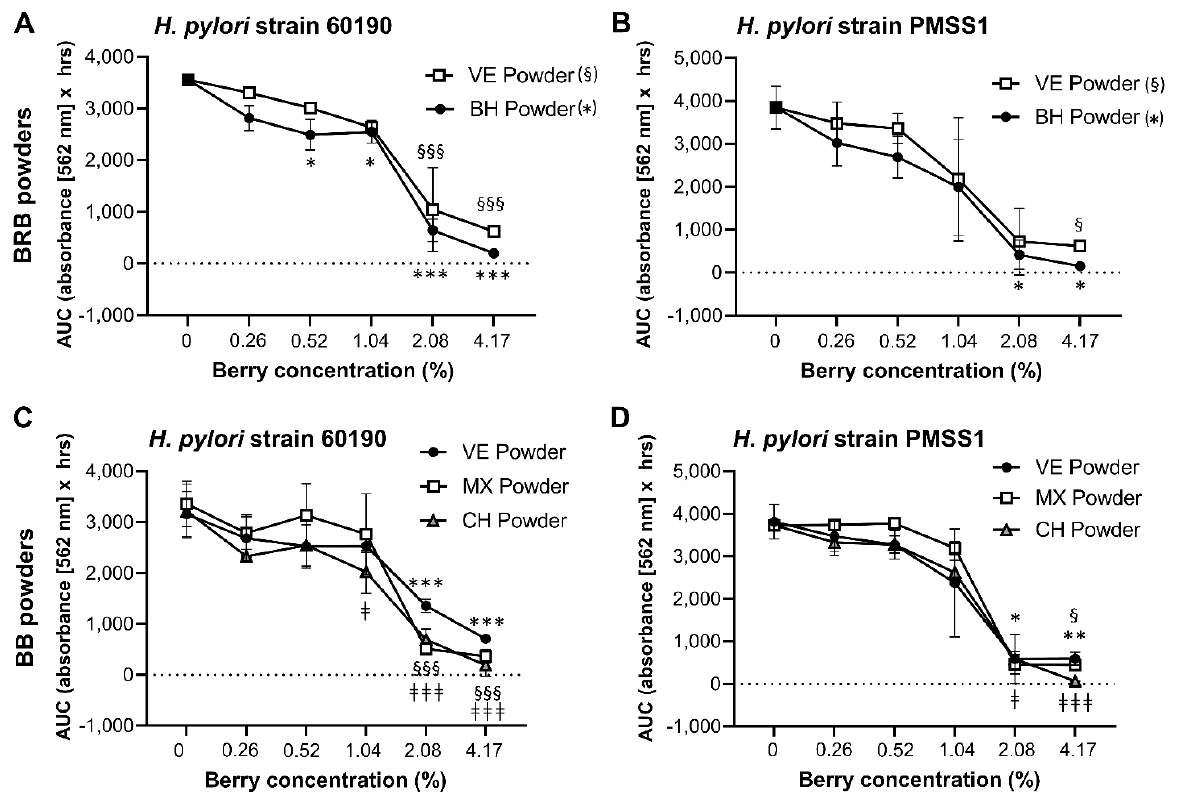
Figure 5. Growth inhibition of H. pylori by lyophilized BRB and BB powder. ( A ) Growth of H. pylori strains 60190 and PMSS1 in the presence of different concentrations of the BRB and BB powders described in Supplemental Tables 1 and 2. Area under the curve (AUC) for metabolic culture activity was measured over 30 h for strain 60190 with ( A ) BRB extracts and ( C ) BB extracts and for strain PMSS1 with ( B ) BRB extracts and ( D ) BB extracts using the OmniLog® assay. Pooled data from n = 2 – 4 independent experiment with 3 technical replicates are shown. Data were analyzed by 2-factorial ANOVA. Tukey’s multiple comparisons test was used to identify differences between a specific concentration of a berry extract and the matching untreated control. Significant differences at p ≤ 0.05/ p ≤ 0.01/ p ≤ 0.001, respectively, are indicated by */**/***, §/§§/§§§ and ‡/‡‡/‡‡‡ as defined in the panel labels on the right.